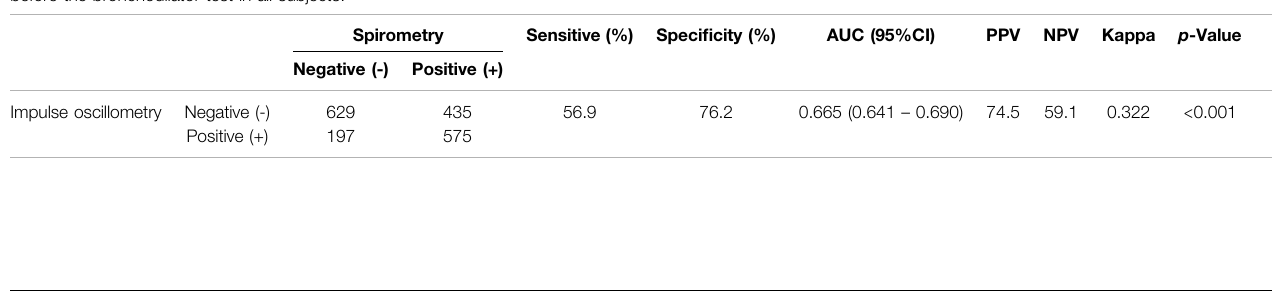
TABLE 2 | Clinical characteristics of SAD patients diagnosed by IOS and spirometry in all